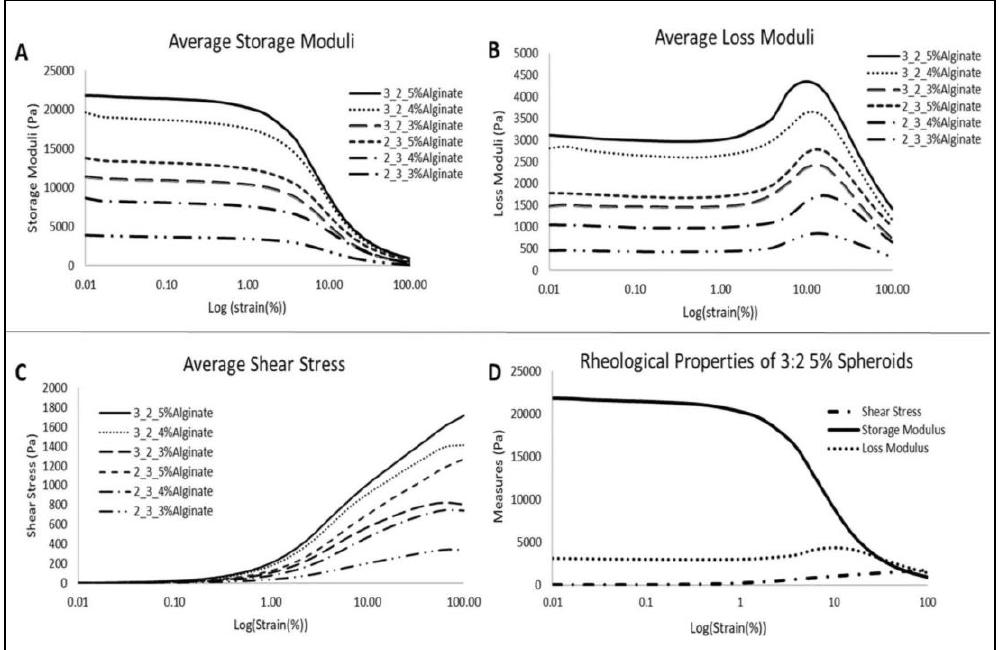
Figure 2. Average storage ( A ) and loss ( B ) moduli were measured for each 3D hydrogel composite to determine the best material for printing cell-laden hydrogels. Storage moduli and loss moduli were highest for the 3:2 5% alginate hydrogels. ( C ) Shear stress plot of the evaluated hydrogels show the 3:2 5% alginate hydrogels with the most resistance to shear stress. ( D ) Rheological analysis of the selected hydrogel composition. Storage modulus and loss modulus values show more elastic than viscous behavior. Shear stress values indicate that the 3D hydrogels cannot sustain large amounts of shear force.